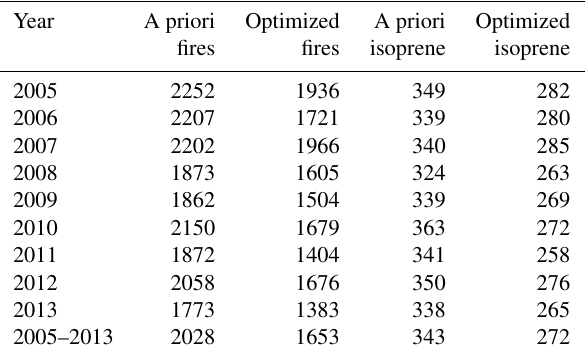
Table 2. Global a priori and OMI-based emission estimates per year. Fire estimates are expressed in Tg Cyear − 1 , isoprene in Tg of iso- prene per year.